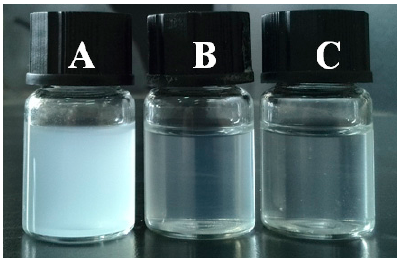
Figure 7. Photographs of anethole solution: ( A ) 0.1% anethole in PBS; ( B ) A 1 -tBP3 (DL = 5.1%); and ( C ) A 2 -tBP3 (DL = 7.9%).